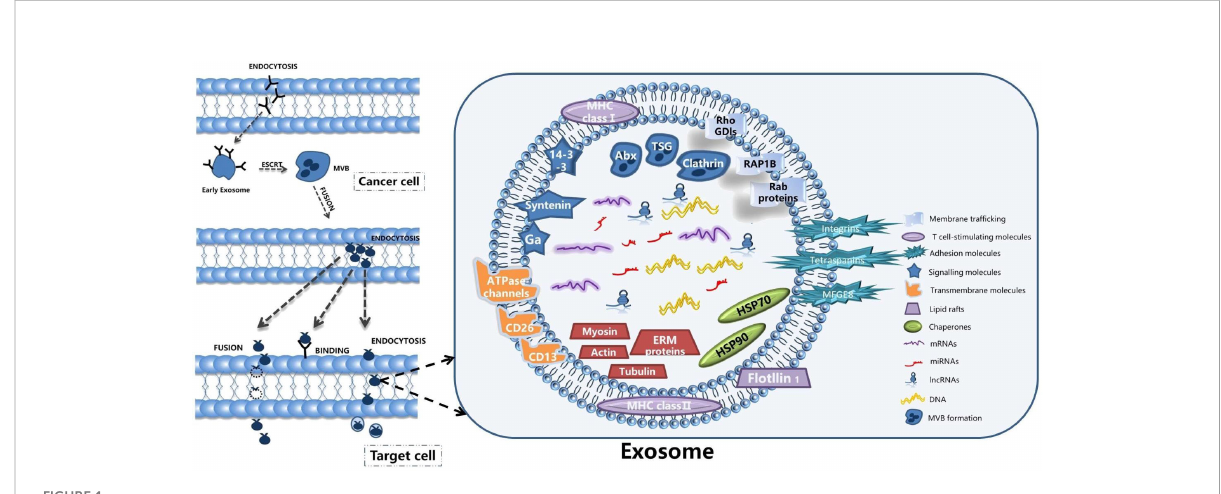
FIGURE 1 The structure and secretion mode of